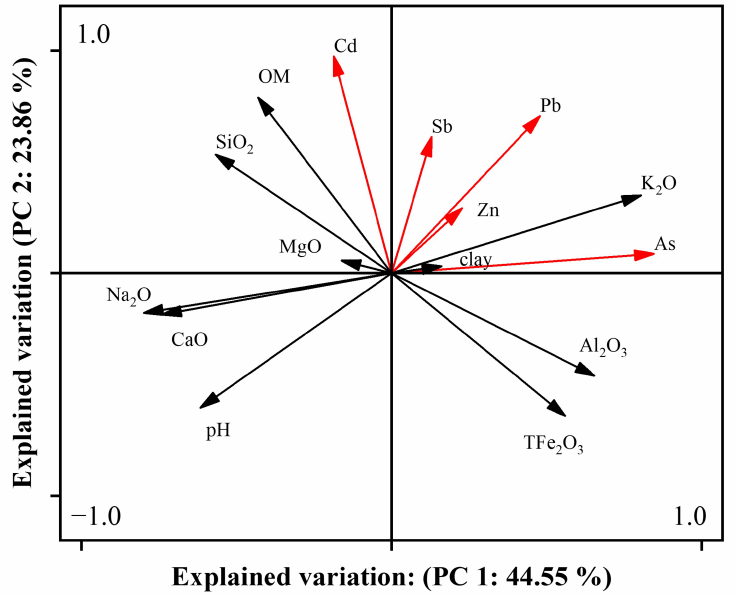
Figure 9. The results of principle component analysis, indicating the sources of soil heavy metals and metalloids. (The red line represents heavy metals and metalloids, the black line represents physical and chemical